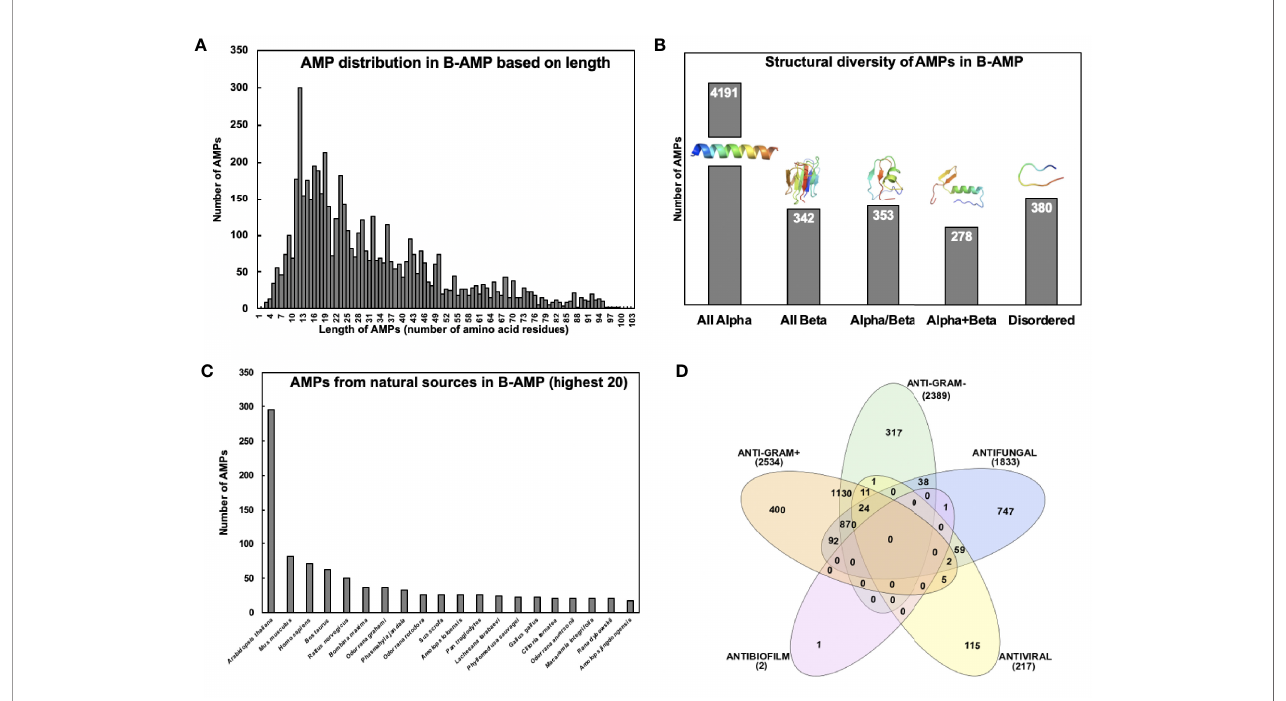
FIGURE 2 | Diversity of AMPs in B-AMP (A) AMPs in B-AMP display a varied distribution in lengths, with the shortest peptide being 2 amino acids in length, and the longest peptide being 102 amino acids in length. However, the vast majority of AMPs are between 5-80 amino acids in length (B) AMPs possess a vast diversity in secondary structures, such as a -helices, b -sheets, coils, loops, and combinations of these structures. The representative structures for a AMP is Pep502- DRAMP02038, all b is Pep2068-DRAMP00932, for a / b is Pep2069-DRAMP00934, for a + b is Pep2070-DRAMP00936, and for disordered is Pep539-DRAMP18376 (C) B-AMP contains AMPs derived from a range of natural and synthetic sources, based on sequences in the DRAMP database. The distribution of natural AMPs based on the highest 20 natural sources reveals plant, animal and human sources (D) AMPs in B-AMP possess a range of antimicrobial activities including antibacterial, antifungal, antiviral and antibio fi lm activity. (B) made using PyMol and (D) made using